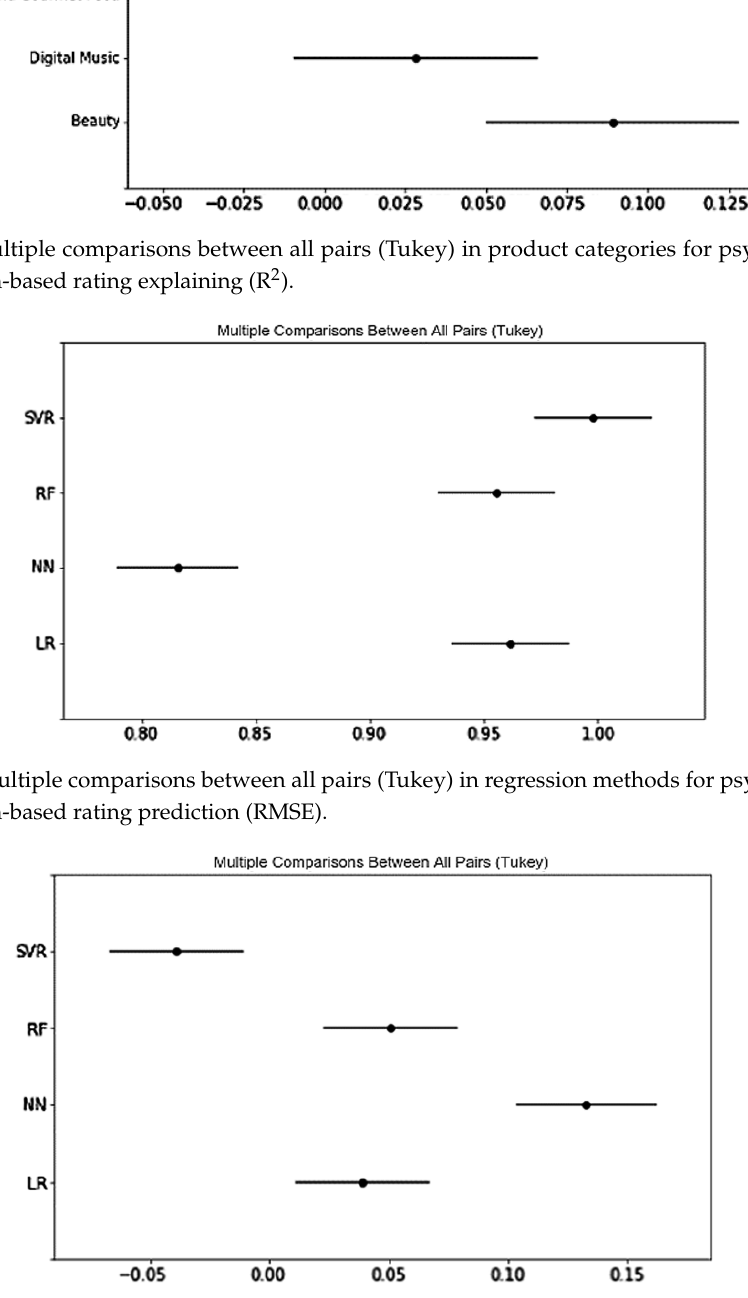
Figure 11. Multiple comparisons between all pairs (Tukey) in regression methods for psychographic segmentation-based rating explanation (R 2 ).